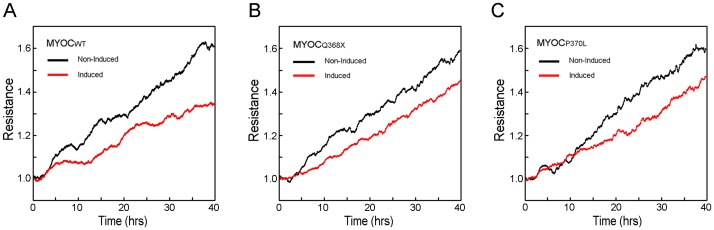
Barrier function in non-induced (black line) and induced (red line) RGC5 cells.The barrier function, evaluated by measuring the total electrical resistance (TER), was impaired in the moderate expressers. A representative TER experiment for each of the wild type (MYOCWT, A), Q368X (MYOCQ368X, B) and P370L (MYOCP370L, C) myocilin pairs is shown.